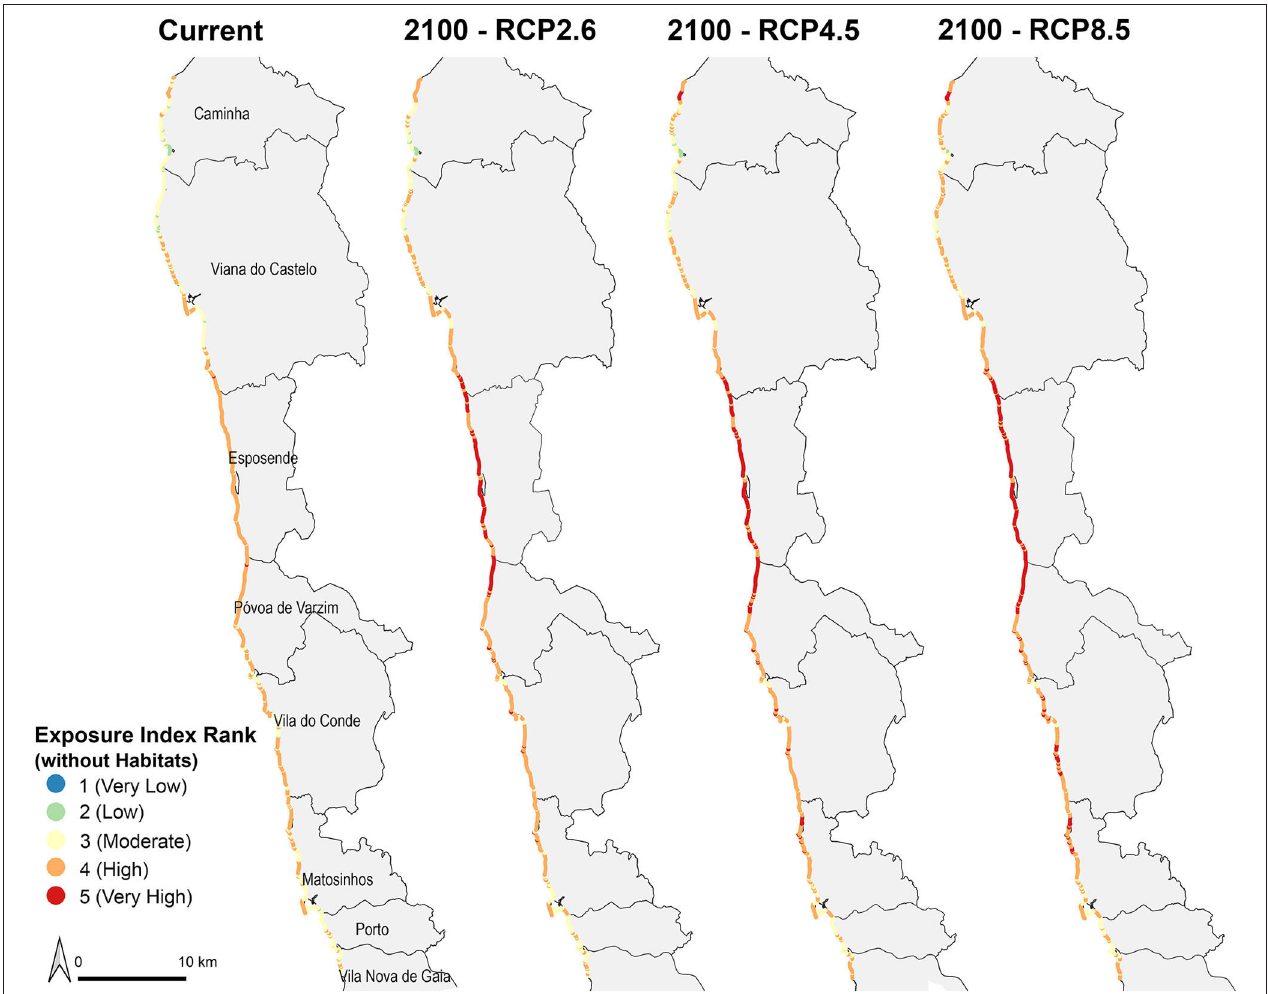
FIGURE 6 | Exposure Index values for the Current scenario and under the different RCP scenarios for 2100 for the northern coast of Portugal, without the contribution of coastal habitats. RCP, Representative Concentration